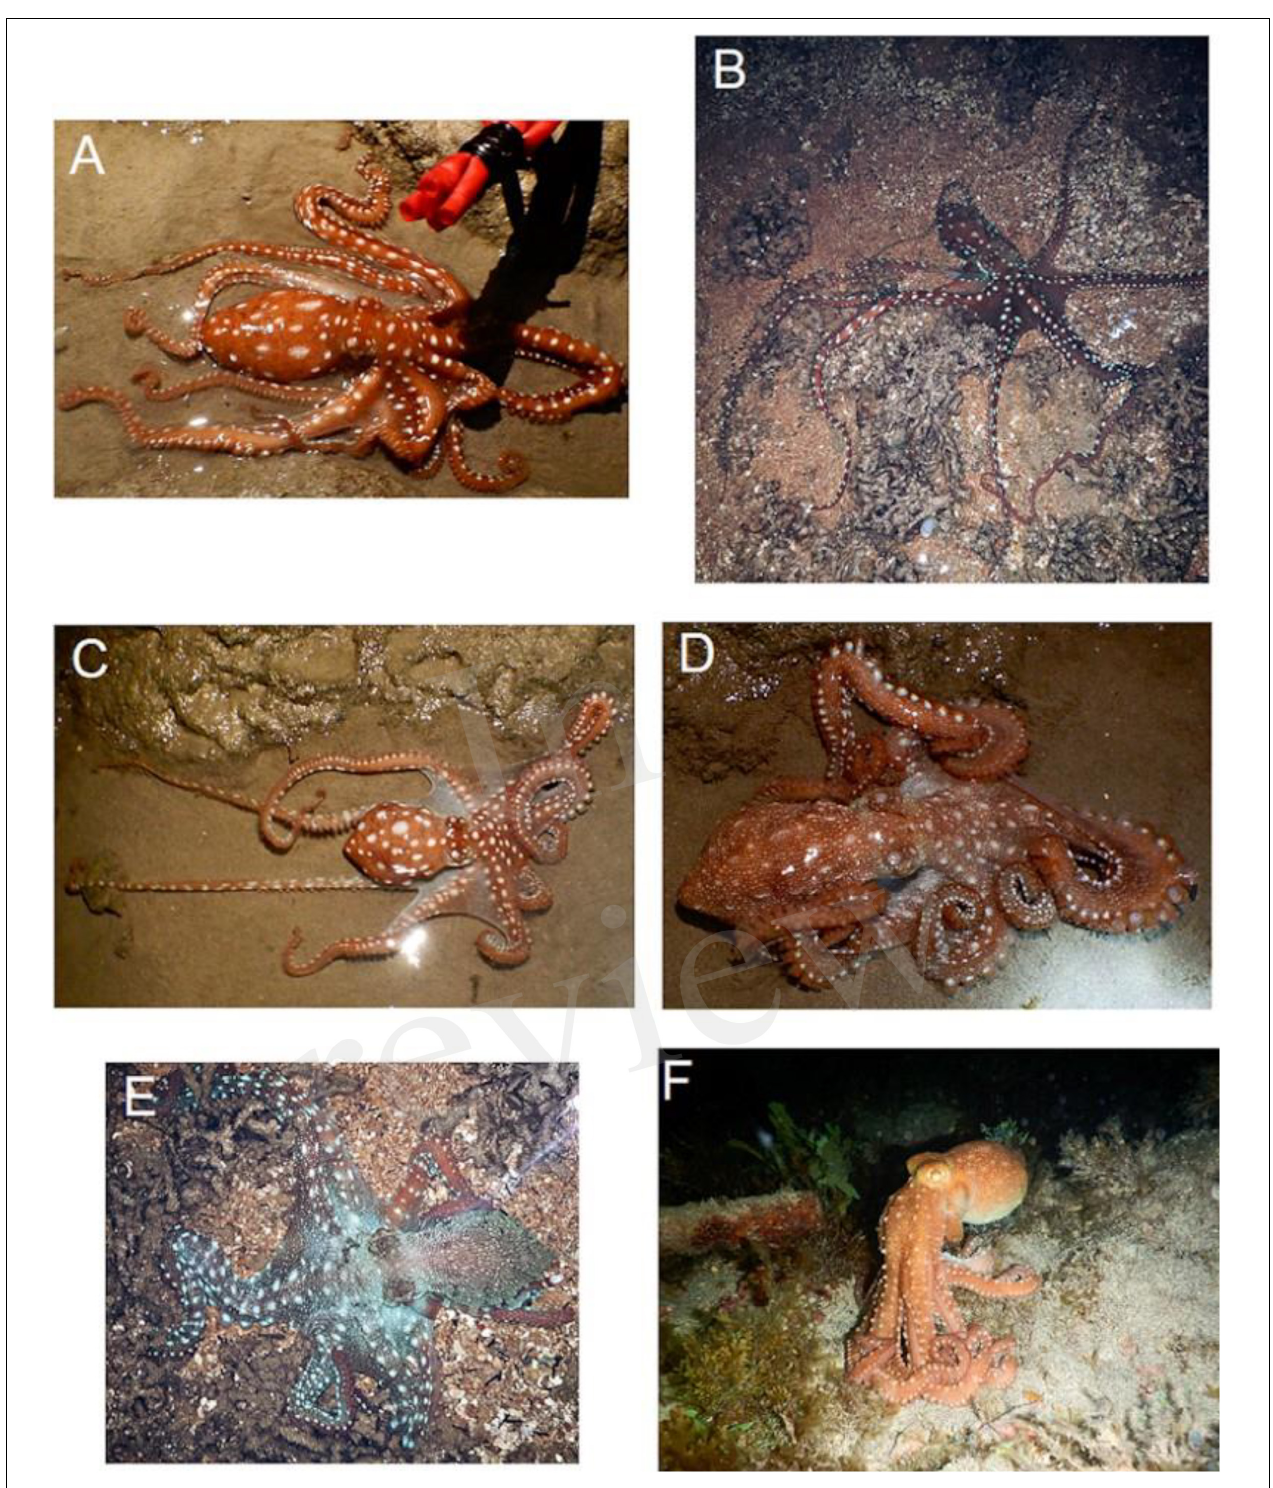
FIGURE 3 | Callistoctopus furvus . Examples of color patterns of living specimens recorded (except F) at Morro de São Paulo (Bahia State). (A,B) Typically brick red color with white spots associated to smooth skin. (C) Red brick color associated to smooth skin with numerous minuscule white spots dotting the superior half of arms and the expanded web. (D) Brick red pattern dotted with numerous minuscule with spots associated to a knobbed texture of the larger white spots. (E) Green-grayish associated with a rugose texture over the whole body and maximally extended rounded and flat dorsal mantle papillae. (F) Uniformly red color associated to distinguishable rows of knobbed white spots on the arms (Abrolhos, Bahia State).